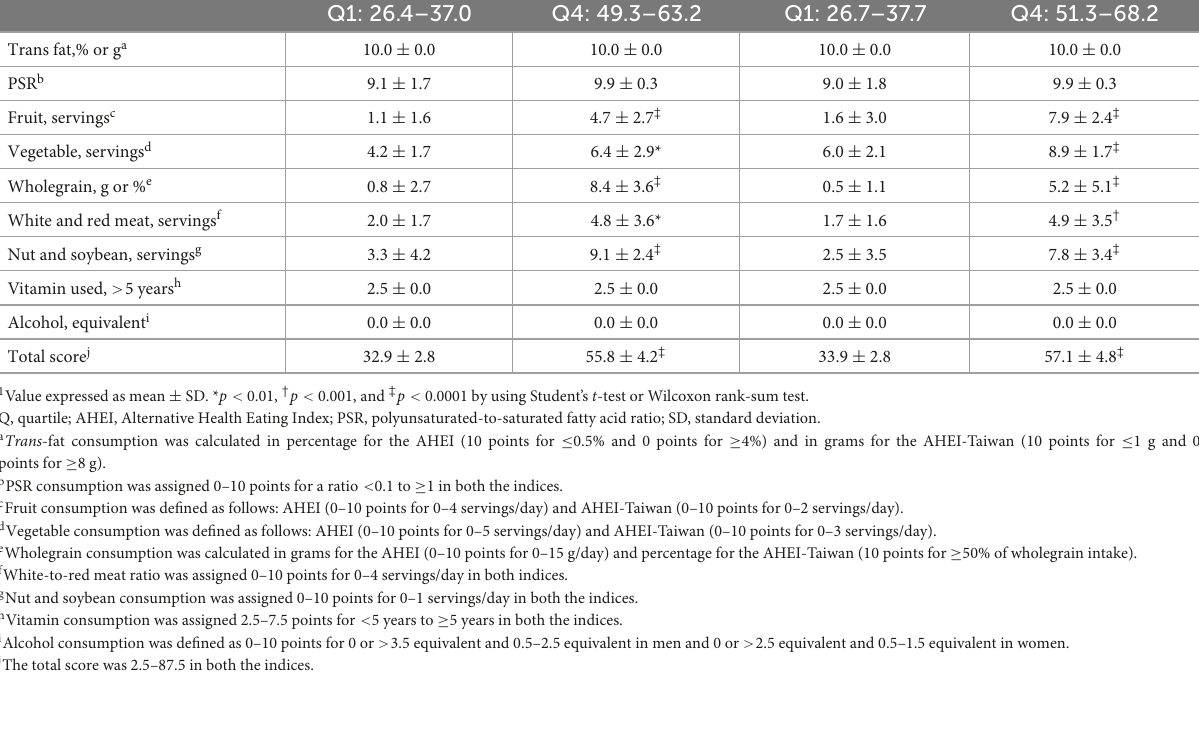
TABLE 2 Comparison of the components and scores between the lowest and the highest quartiles of AHEI and AHEI-Taiwan dietary scores 1 .